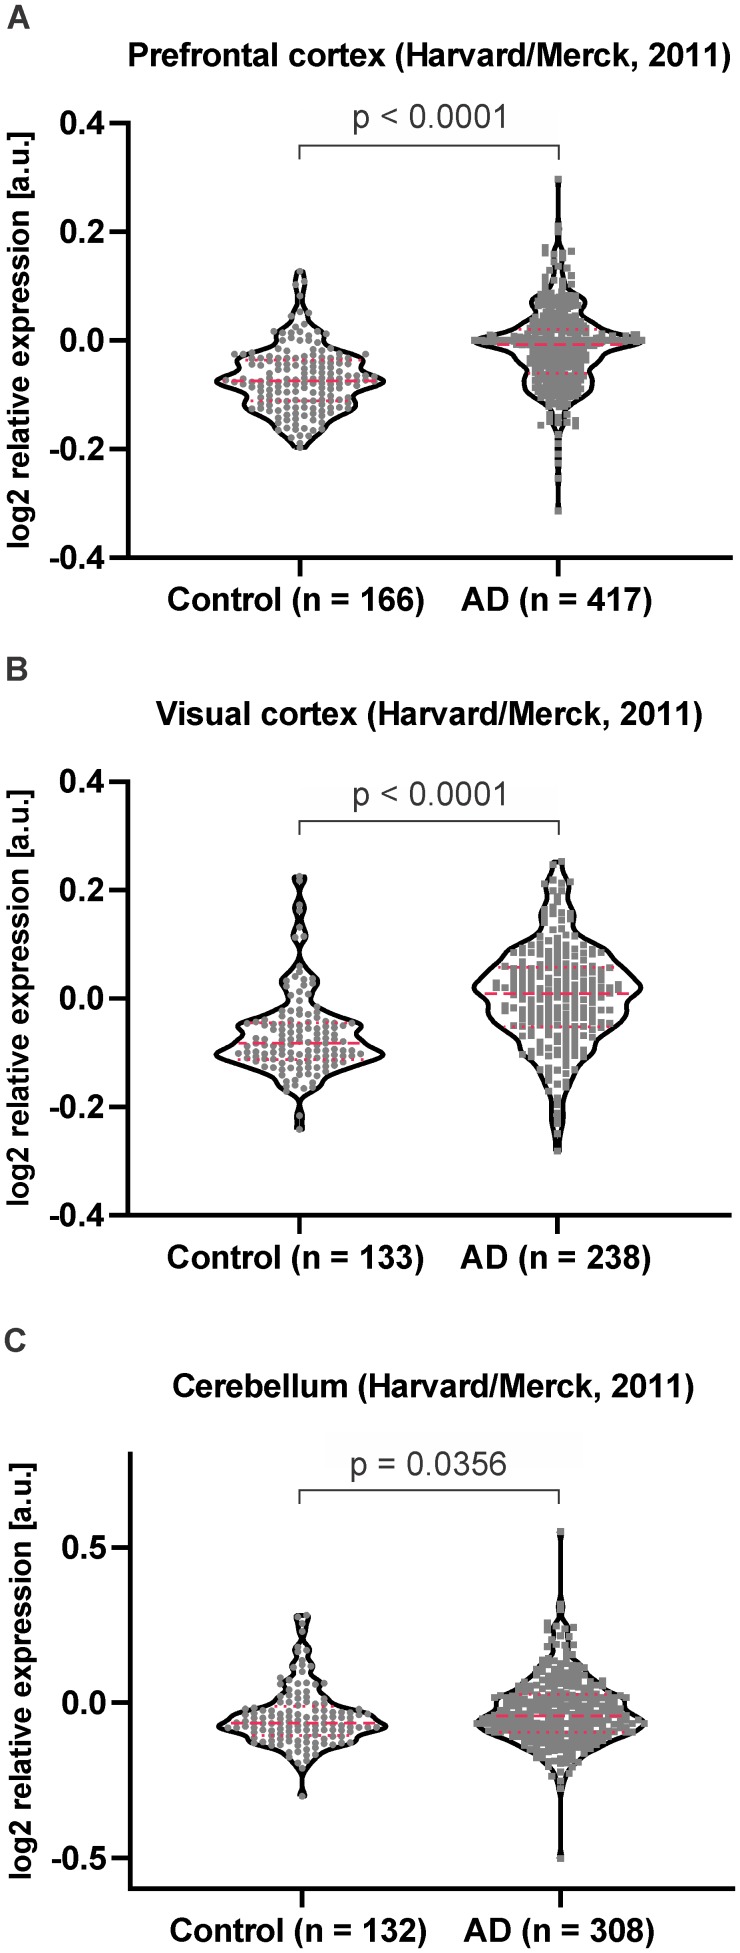
HEBP1 expression in publicly available transcriptome databases of Alzheimer’s disease.In silico analysis of HEBP1 mRNA expression in AD patients and matched controls based on publicly available data from Harvard Brain Tissue Resource Center (HBTRC) deposited on GeneNetwork (www.genenetwork.org) (see Materials and methods for details). HEBP1 expression in prefrontal cortex (A), primary visual cortex (B) and cerebellum (C) is significantly elevated in AD patients. Violin plots represent all analyzed values. Dashed and dotted red lines indicate median and the 25th or 75th percentile, respectively. Number of patients per group is indicated at the x-axes on the graphs. Mann-Whitney test was used to assess statistical significance.